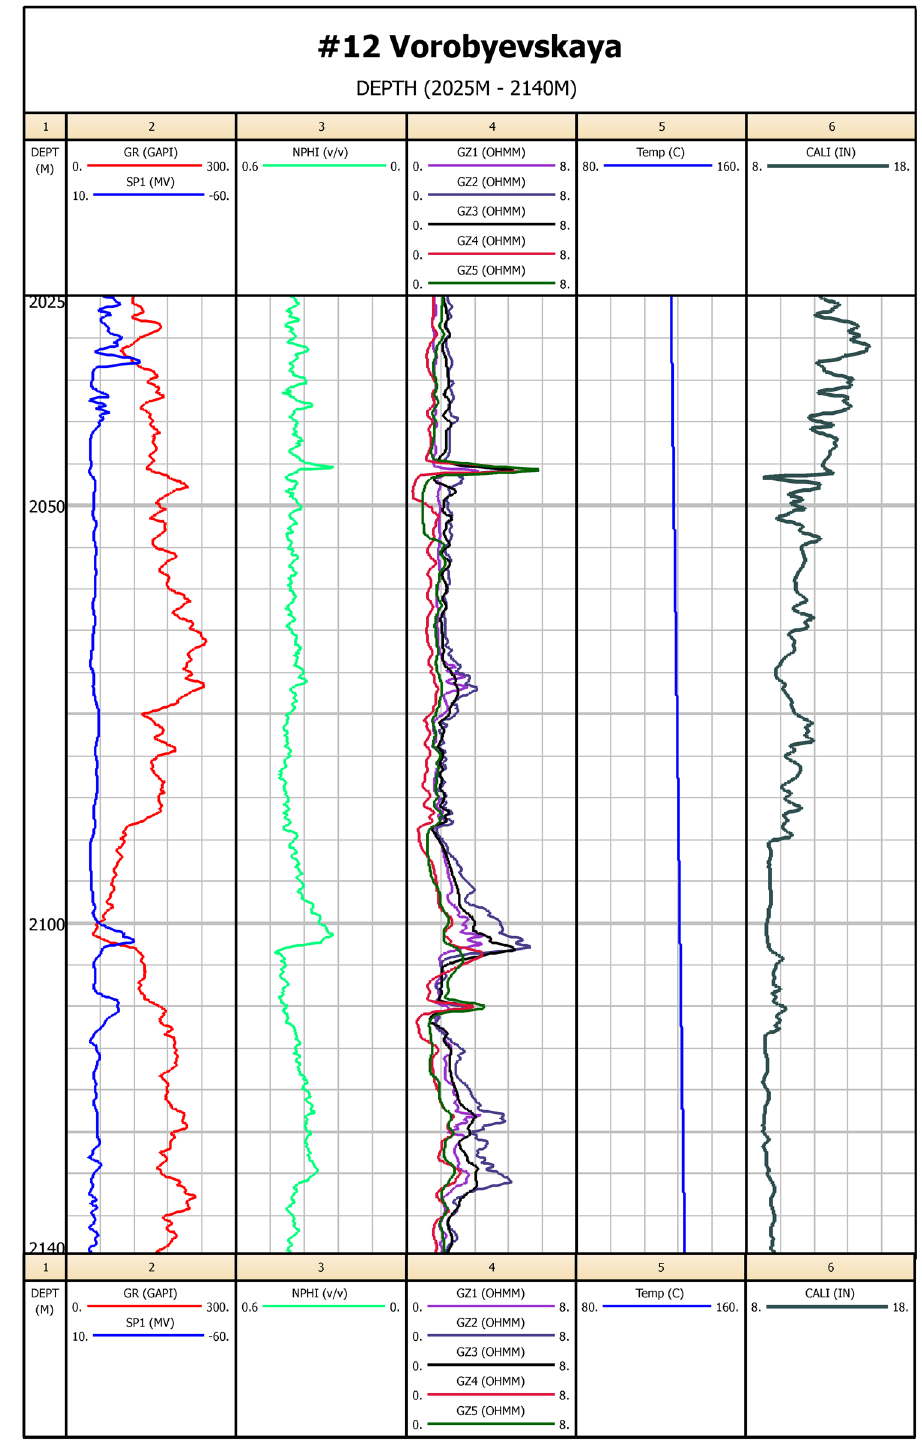
Fig. 11 Wireline logs for the Well # 12